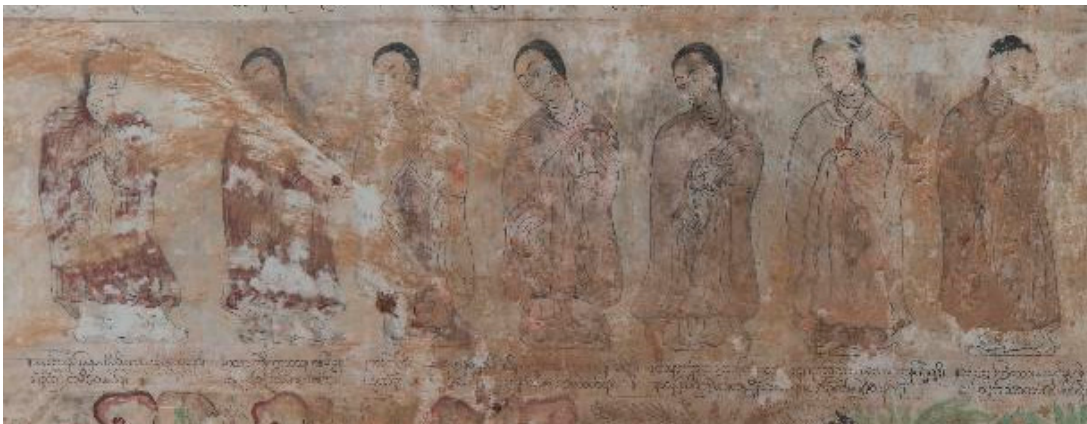
Figure 45. Pagan, Sulamani, images dating to the 18th century. Gotami and the paradigmatic Bhikkhuni(s).